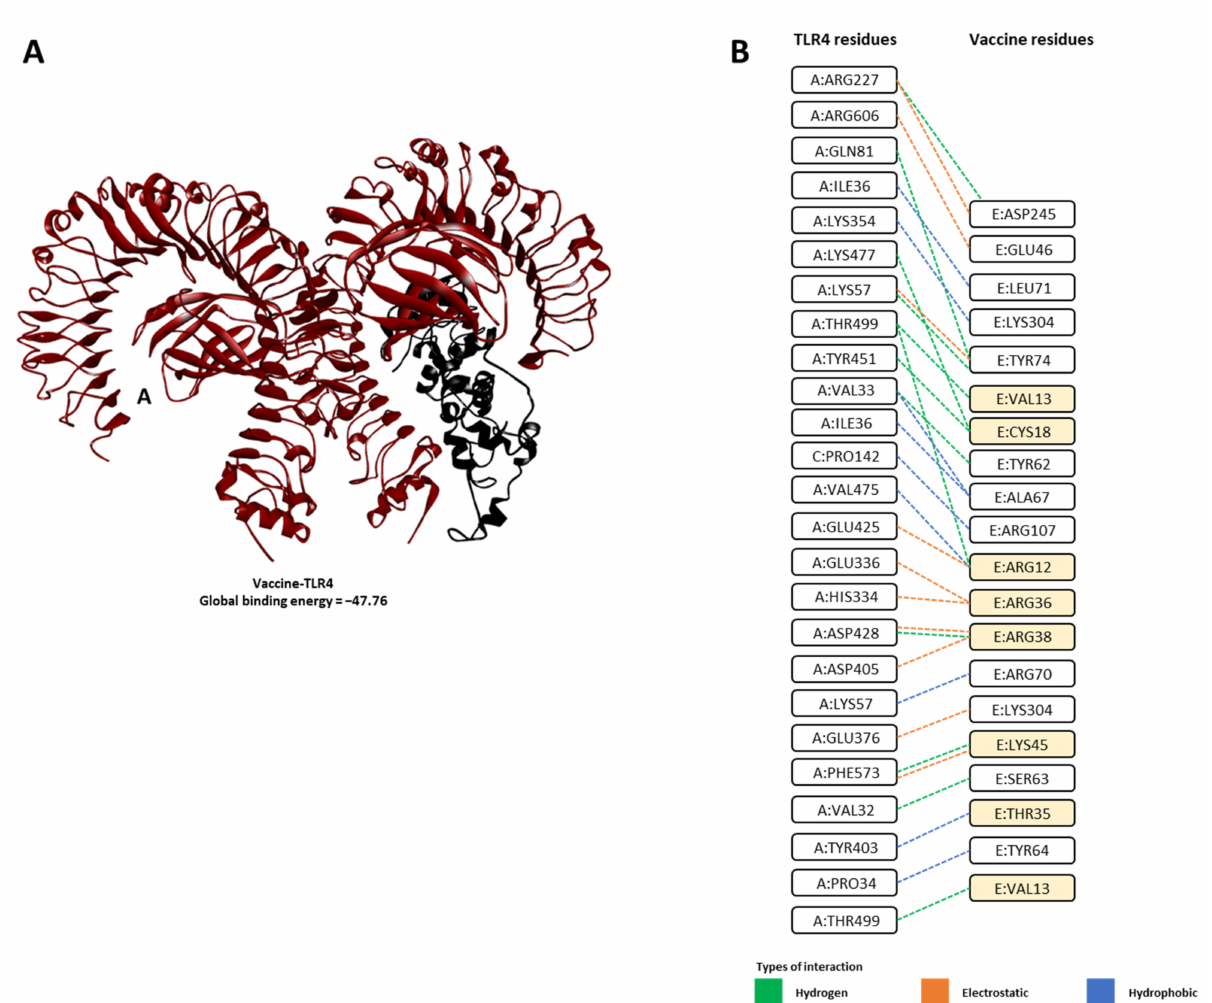
Figure 5. Molecular docking analysis between vaccine construct and TLR4. ( A ) Docked complex of the designed vaccine with TLR4, ( B ) amino acid interaction between vaccine–TLR4 (vaccine construct: chain E; TLR4: chain A; C: Lymphocyte antigen 96), resolved using LigPlot+ (DIMPLOT). Residues that are part of β -defensin found to interact with TLR4 are highlighted in